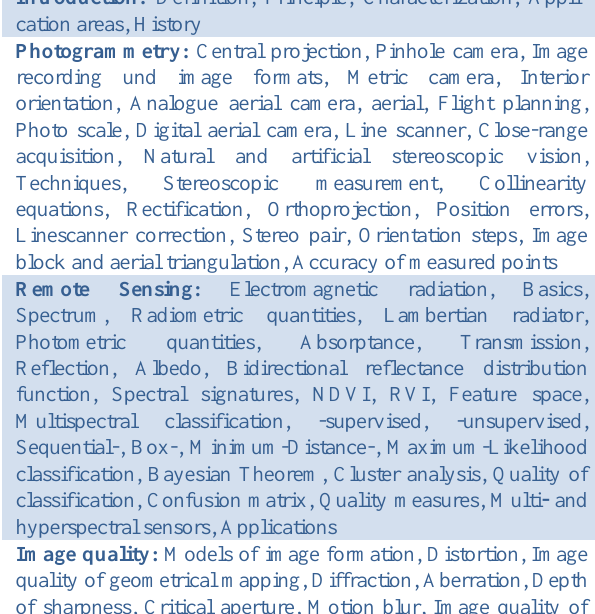
Table 4. Topics addressed in the lecture ‘ Introduction to